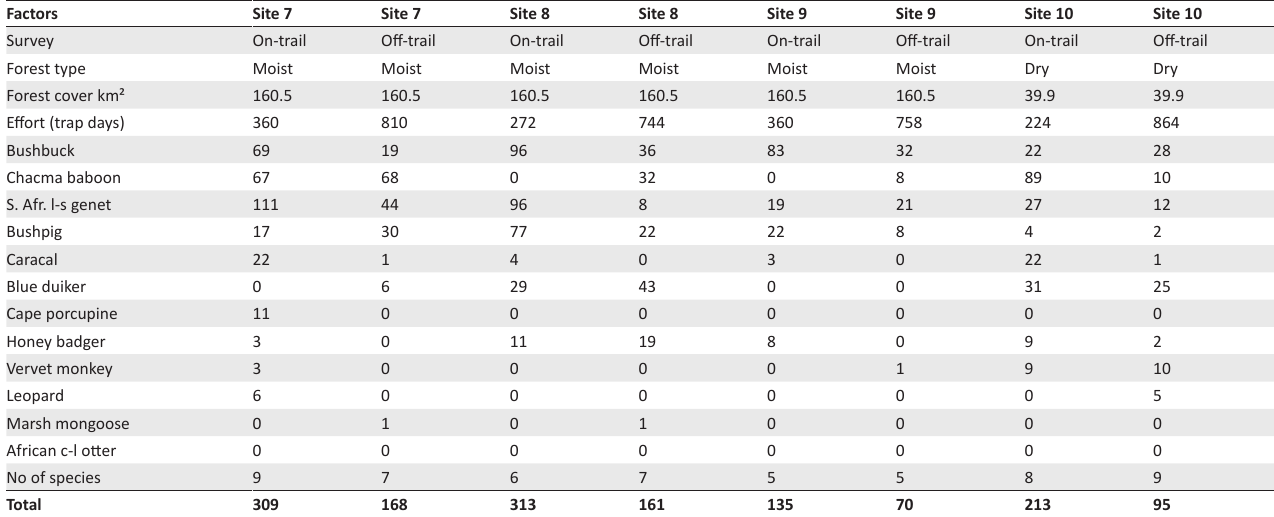
TABLE 2: Forest characteristics, sampling effort and numbers of photographic captures (expressed as records per 1000 trap days) of the different species recorded at Sites 7–10 during on-trail and off-trail trapping. Factors Survey